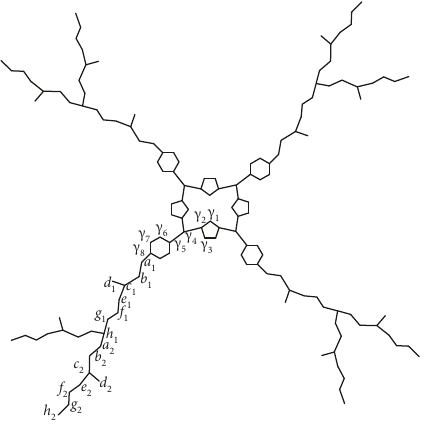
Figure 3: Labelled molecular graph P 2 ( 2 ) . n with degree, eccentricities, and their frequencies. 2 ( )